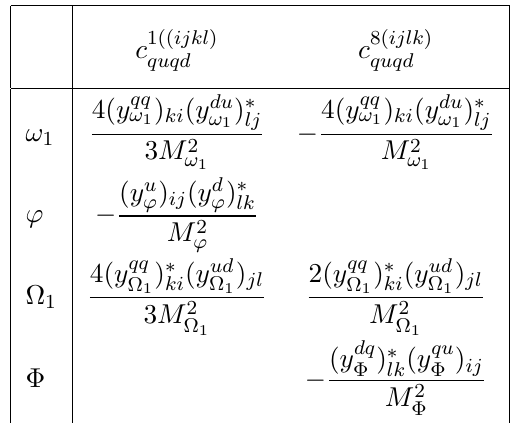
Table 10 . Field-by-(cid:12)eld contribution to four-fermion operators.